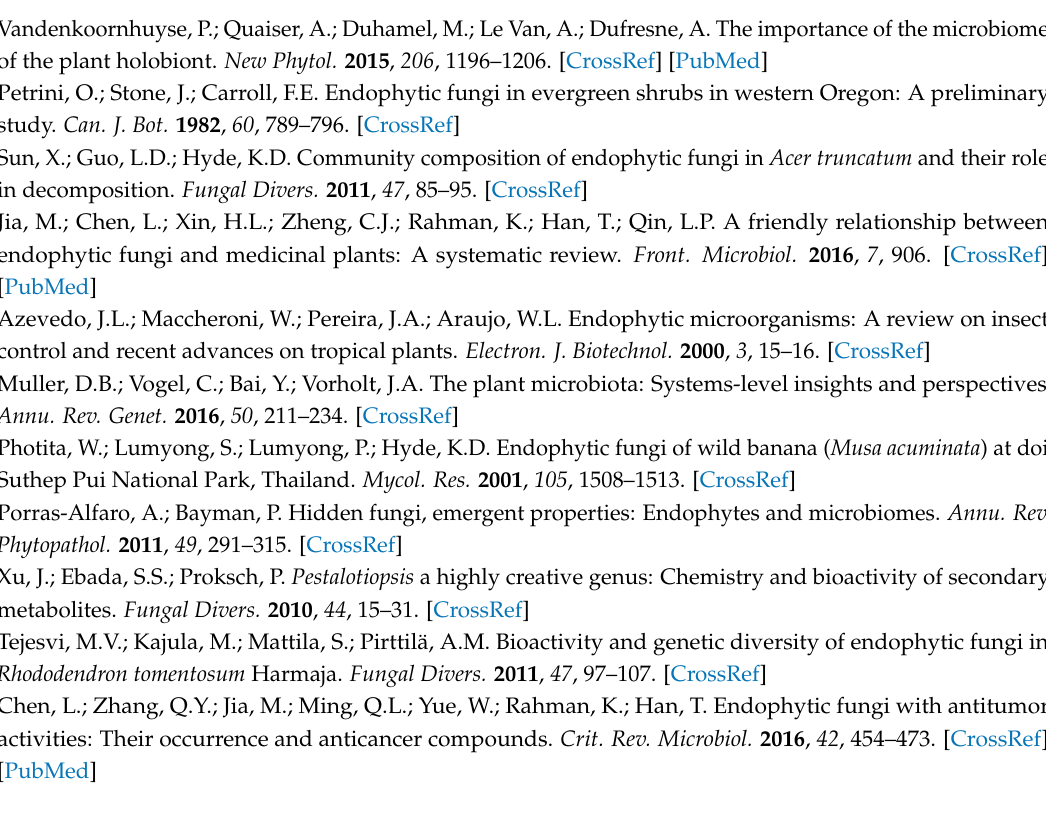
Figure S1. Statistically significant differences in the fungal species richness (A), diversity (B) and evenness (C) of the samples, * 0.01 < p ≤ 0.05, ** 0.001 < p ≤ 0.01, *** p ≤ 0.001. Figure S2. Rarefaction curves of all the samples. All the samples are saturated for further study. Figure S3. Significantly different taxa among samples. (A) at phylum level, (B) at class level, (C) at family level, (D) at genus level, (E) at species level, (F) at OTU